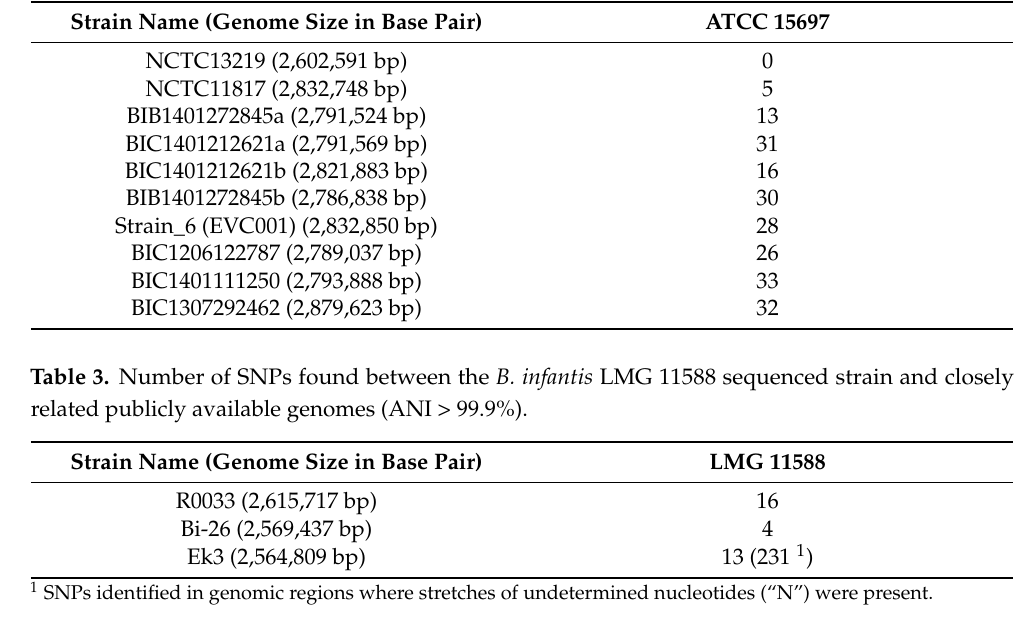
Table 2. Number of SNPs found between the B. infantis ATCC 15697 sequenced strain and closely related publicly available genomes (ANI > 99.9%).